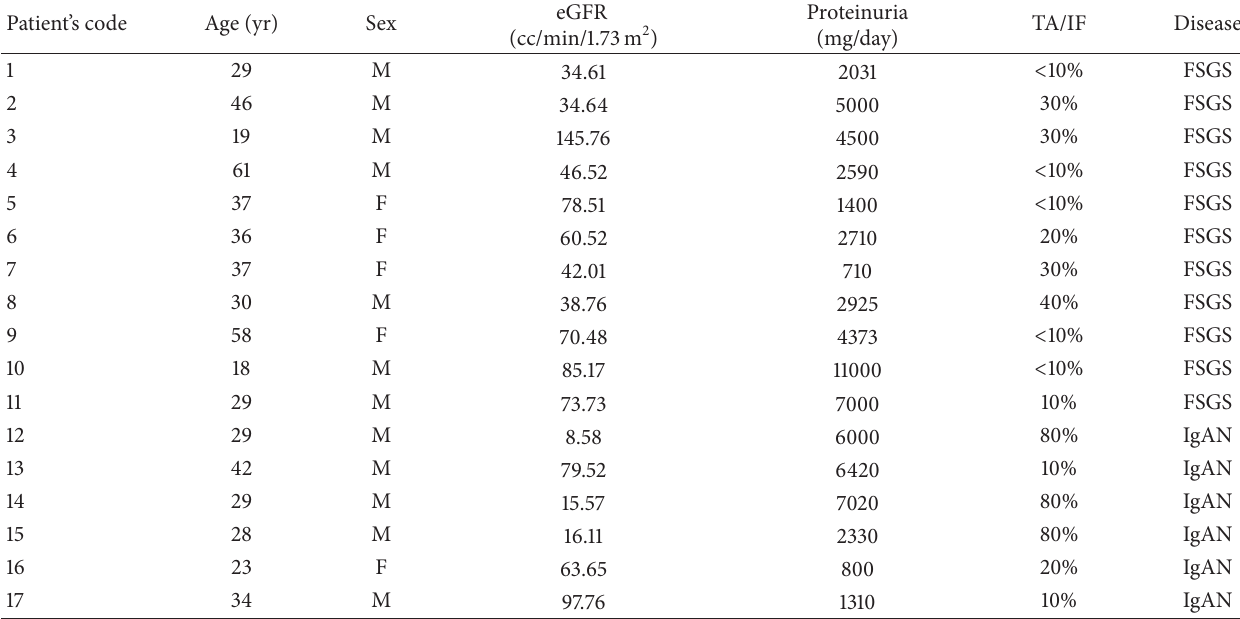
Table 1: Demographic and laboratory characteristics of patients with focal segmental glomerulosclerosis and IgA nephropathy. Patient’s